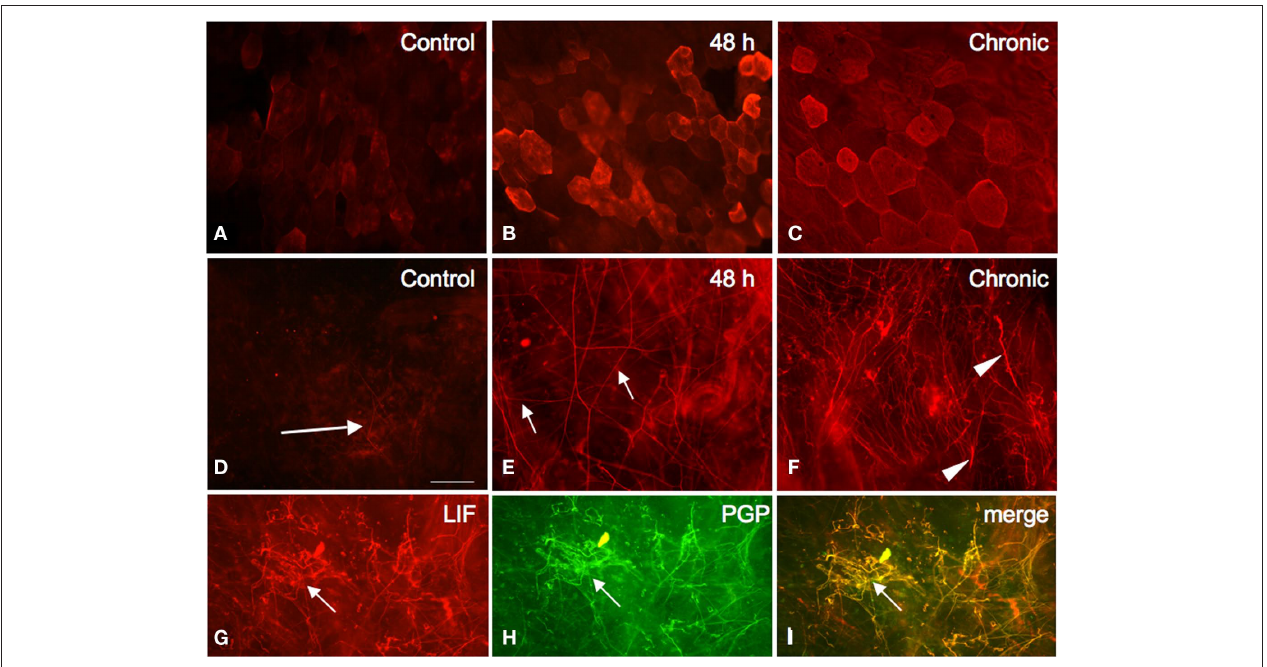
neck region increased in density with CYP-induced cystitis [48 h (e) and chronic (F) ] compared to control (D) . Arrows (D,e) and arrowheads (F) indicate small or large caliber LIF-IR nerve fibers respectively. With CYP treatment [chronic, (g–I) ], LIF-IR in nerve fibers (g) in the suburothelial plexus exhibited complete overlap (I) with PGP9.5 (H) , a pan neuronal marker. Calibration bar represents 80